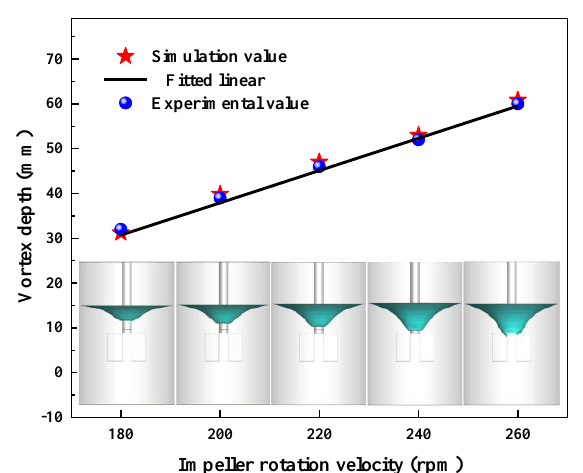
Figure 17. Vortex depth and gas – liquid interface profile at different IRSs with IIDs of 110 mm.